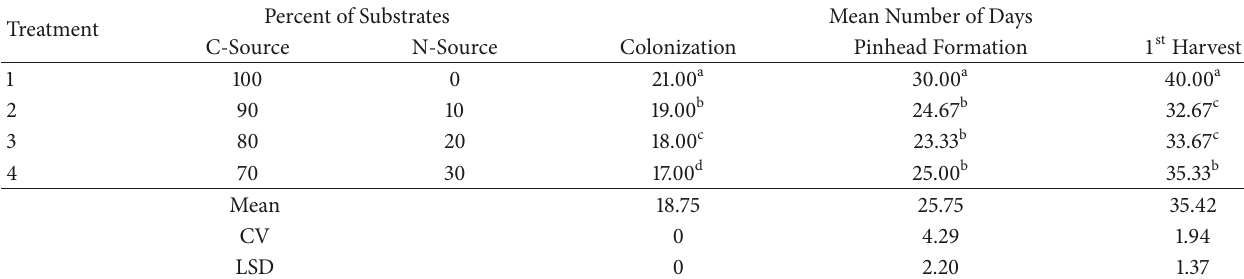
Table 1: Effects of different substrates on the growth rate of grey oyster mushroom ( P. sajor-caju ).